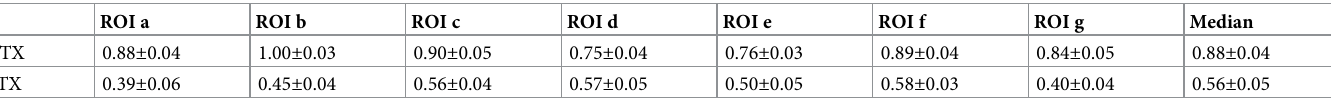
homogeneity is dependent on different prerequisites of the applied coil and the imaged object. The visibility of stenoses depends on the signal of the stenosis vs. the surrounding variation of signal intensities on a pixel-by-pixel basis. Thus, the reason for the superior stenosis evaluation with pTX and B -shimming possibly lies in reduced B 1+ -inhomogeneity because local varia- 1 tions of B 1+ -induced signal variations may diminish the visibility of the stenosis. However, this finding may also be caused by overall higher SNR values compared to the conventional coil. Other reasons might be image errors, e.g. based on slice selection, in areas of inhomogeneous + or a combination of these mechanisms. In the context of this study, the underlying causes B 1 could not be fully identified and require further in-depth analysis. In this study, two observers rated images of stenosis phantoms acquired with different Gd- DOTA concentrations typical for human studies. Both full and half concentration of a conven- tional Gd-DOTA dose for humans were equally suitable for stenosis evaluation. These results suggest that lower gadolinium concentrations than customary at 1.5 and 3 T may be sufficient for stenosis grading at UHF-CMR. In terms of patient safety, the application of reduced con- trast agent concentrations without loss of image information is beneficial [33–35]. These find- ings are in concordance with previously published brain UHF-MRI studies [6, 36]. The results from this study also indicate that local B 1+ -inhomogeneities may severely impair stenosis evaluation under certain conditions. In a phantom study, local signal drops may be corrected manually by repositioning of the imaged objects, adjusting the load of the coil, or changing imaging parameters. Under in-vivo conditions, however, this approach is hampered since it is hardly possible to detect slight shading artifacts overlaying small coronary vessels in the complexity of the human heart. Furthermore, the position of signal drops cannot be pre- dicted reliably. Automated B -shimming and pTX might overcome these constraints to some 1 degree and improve imaging of small vessels such as coronary arteries. Future studies should further address challenges with B - and B 1+ -inhomogeneity at 7 T to take advantage of 0 increased SNR at ultra-high fields. This approach may help to enhance the diagnostic value of CMR and its current limitations at 1.5 and 3 T, since higher SNR may be used for improved spatial resolution or shorter scan times and thus reduce influence of motion. The imaging parameters and phantom dimensions in this study were selected to be as close as possible to a human application. To enhance transferability, acquisition time was chosen to be similar to in-vivo measurements using breath-hold techniques. However, in-vivo conditions differ substantially from our thorax phantom due to overall SNR levels as well as susceptibility changes between different tissues, and motion artifacts. Hence, for a transfer to a human Table 4. Mean signal-to-noise ratio (SNR) values and standard deviation in the thorax phantom of the surrounding tissue (outside the stenosis phantoms). ROI a ROI b ROI c pTX 0.88 ± 0.04 sTX 0.39 ± 0.06 The ROI selection is displayed in Fig 2. Overall, SNR was distinctly higher with B 1 -shimming and pTX than with the conventional sTX